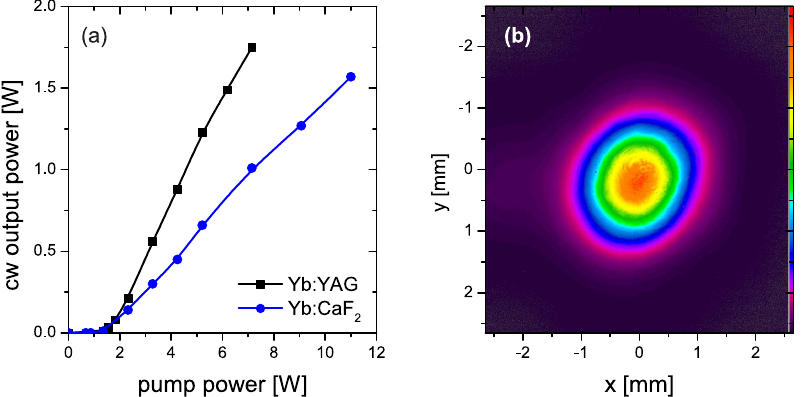
Figure 3. ( a ) Laser output power vs. pump power at continuous-wave operation; ( b ) output beam profile with a size of 2.8 mm (D4 σ x width) and 2.5 mm (D4 σ y